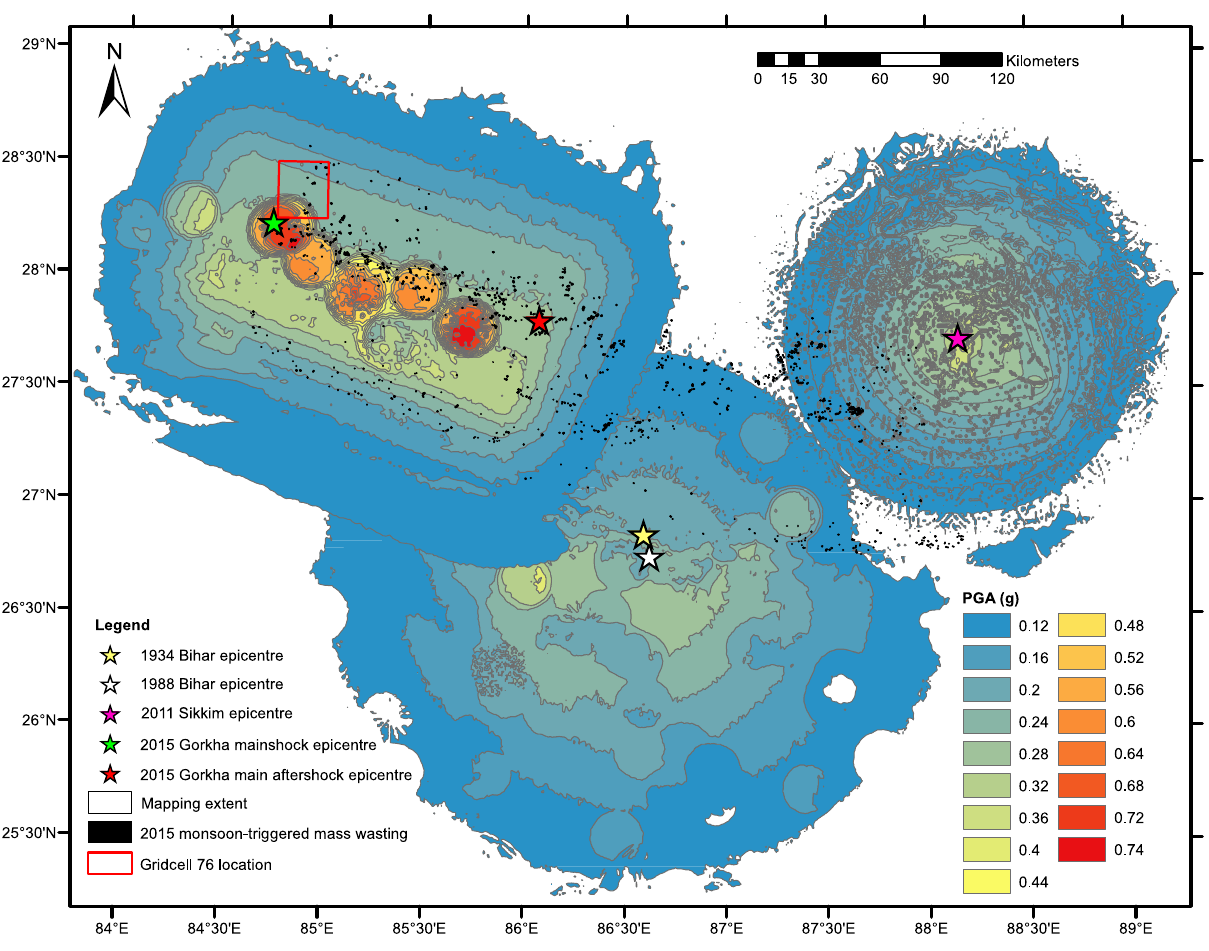
Fig. 7 The locations of the epicentres of the 2015 M w 78 Gorkha earthquake main shock, the 2015 M w 7.3 largest aftershock, the 2011 M w 6.9 Sikkim earthquake, the 1988 M w 6.9 Bihar earthquake and the 1934 M w 8.0 Nepal – Bihar earthquake. Also shown are the USGS estimated PGA distributions for the 2015 Gorkha main shock, and the 1988 and 2011 events 45,84,85 and the location of possible outlier grid cell